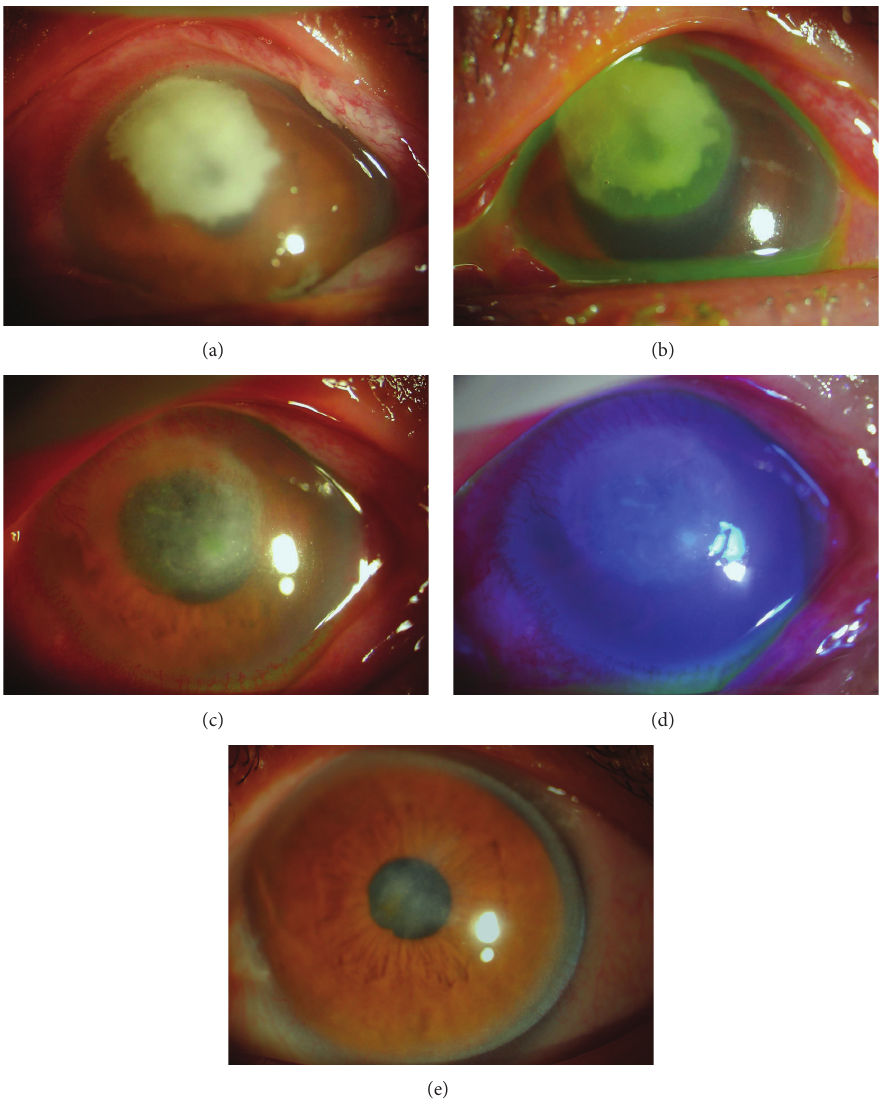
Figure 1: A patient with fungal keratitis. The patient’s cornea is shown preoperatively with the lesions located in the anterior stroma (a) and by fluorescein staining (b). The cornea is shown at eight days postoperatively with phototherapeutic keratectomy (c) and with complete reepithelialization (d). The patient, at 18 months postoperatively, shows a smooth corneal surface with mild haze (e), and the best-corrected visual acuity is 0.5 (+2.50 DS ∗− 2.00 DC × 55 ∘ ). The thinnest thickness of ablation zone is 472 𝜇